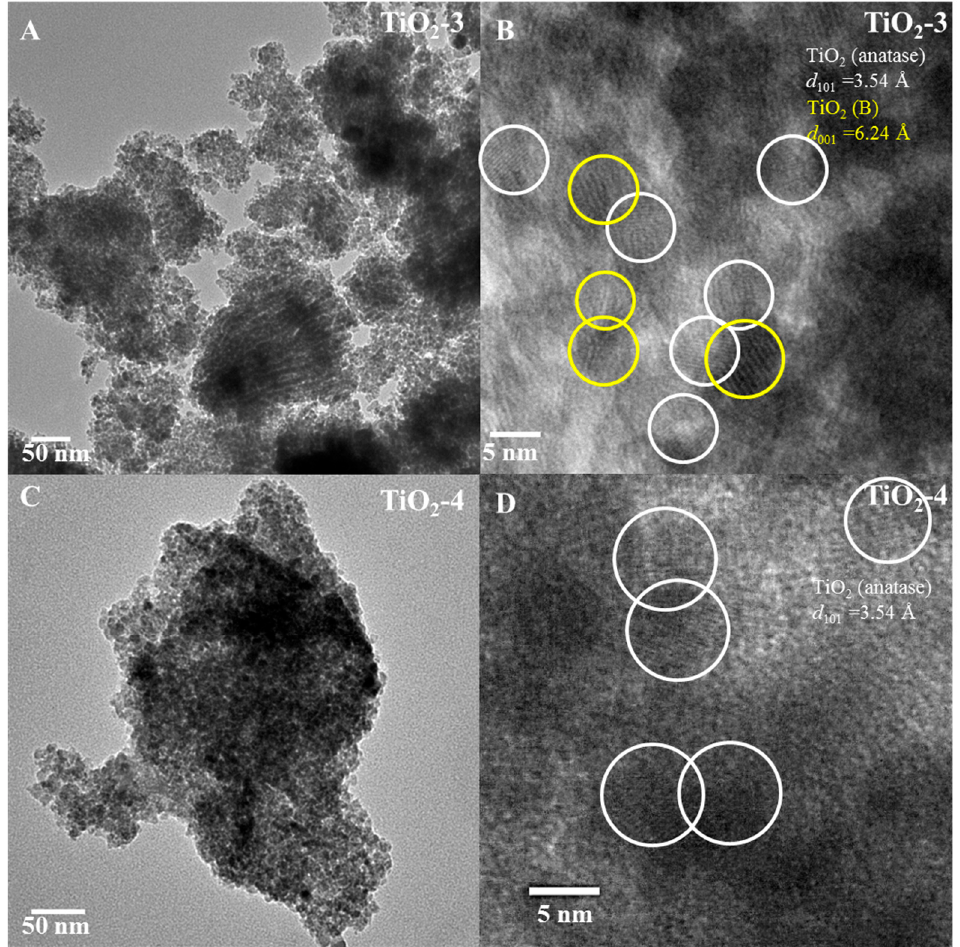
Figure 5. TEM images. TiO 2 -3 (( A ) low magnification and ( B ) high magnification) and TiO 2 -4 (( C ) low magnification and ( D ) high magnification) nanocasted titania mesoporous materials. The yellow and white circles indicate TiO 2 (B) and anatase phase respectively.